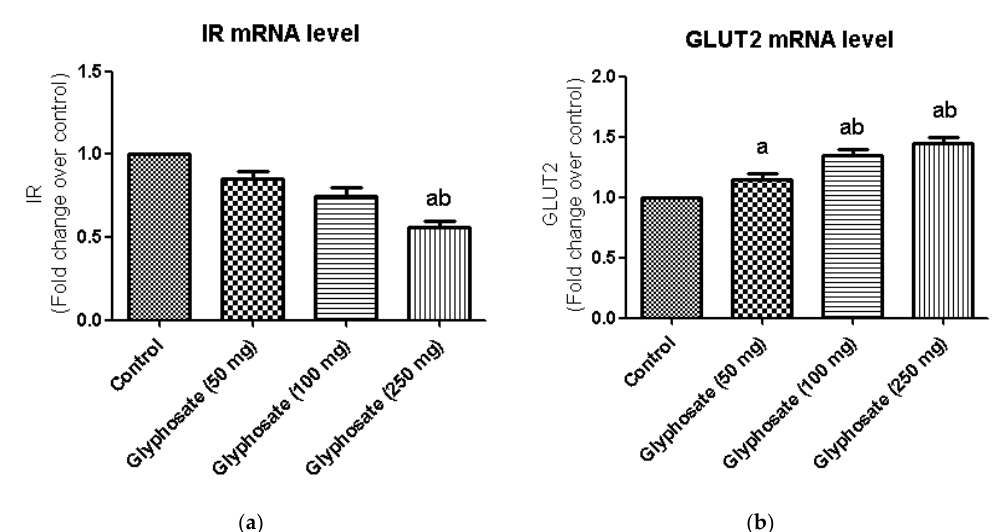
Figure 5. ( a , b ): The effect of glyphosate on mRNA levels of IR and GLUT2 in control and glyphosate treated rats. IR and GLUT 2 mRNA expression were analyzed by Real Time-PCR using gene specific primers and results were expression in fold-change over control. Data were expressed as mean ± SEM where n = 6 rats for each group. Values significant at p < 0.05 were analyzed with a — control, b — glyphosate (50 mg/kg b.wt.). 3.9. Impact of Glyphosate on the mRNA Expression of Transcriptional Factors like PPAR- γ and SREBP1c Major transcriptional factors of hepatic insulin signalling like SREBP1c and PPAR- γ